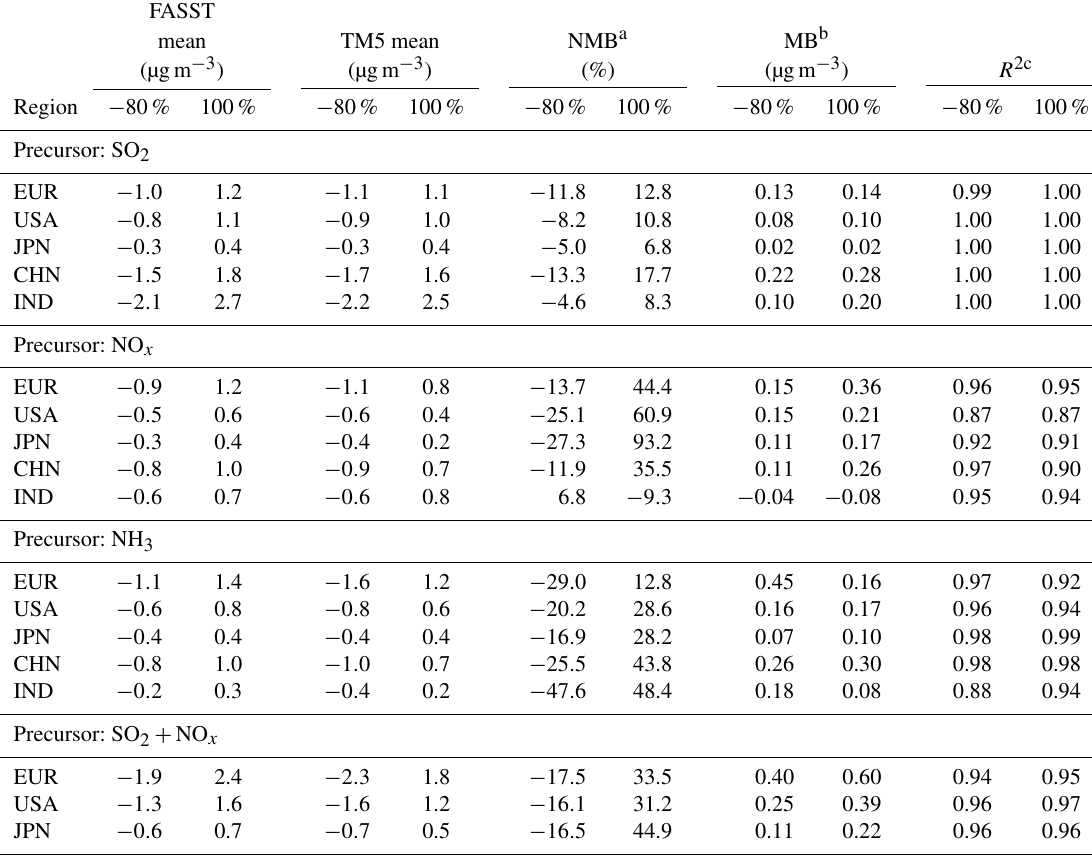
Table 4. Statistical metrics describing the correspondence between the linearized FASST- and TM5-computed change in secondary PM 2 . 5 upon − 80% and 100% emission perturbation in its precursors (SO 2 , NO x , NH 3 , and combined SO 2 + NO x ), relative to the RCP2000 base scenario. Statistics are calculated over all 1 ◦ × 1 ◦ grid cells in each region. Statistics for total concentrations are given in Sect.